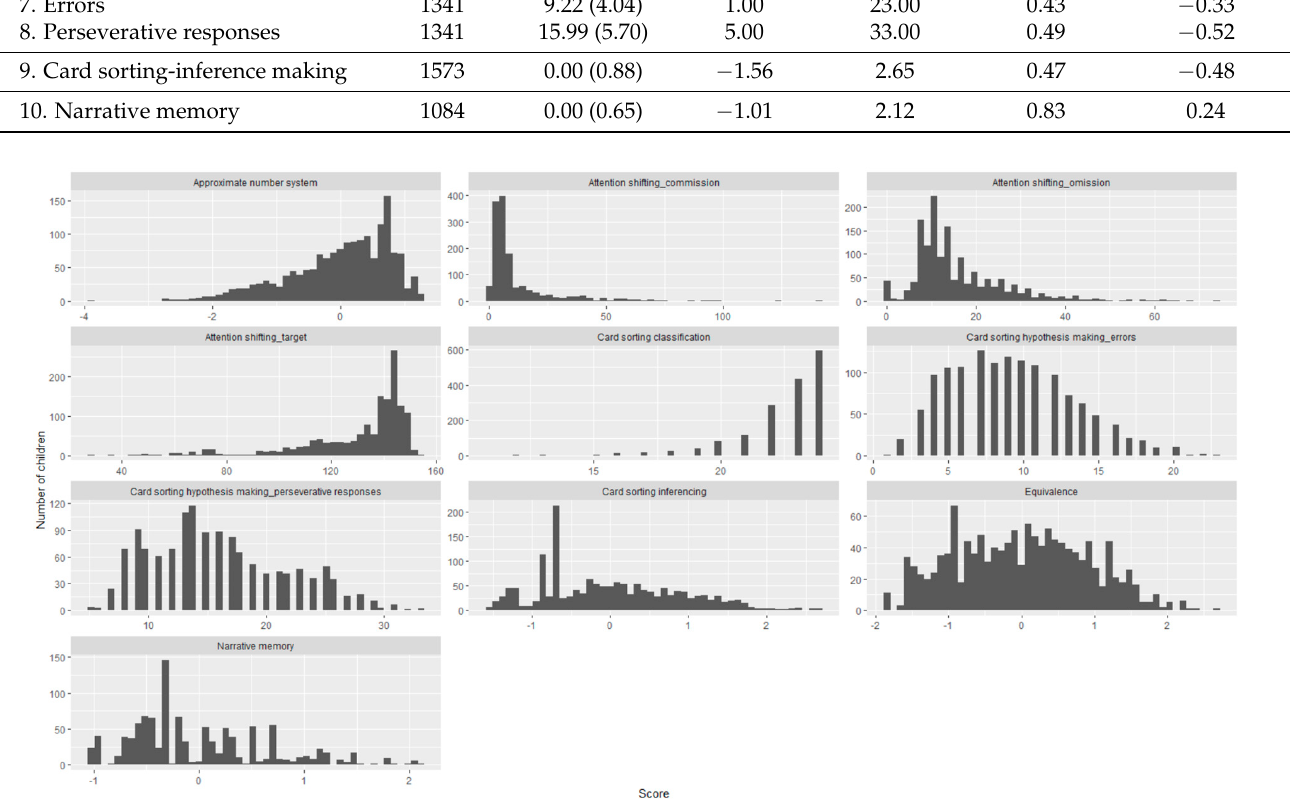
Figure 2. Score distributions of subtest case examples. Table 4. Pearson correlation coefficients between age and subtest case examples.